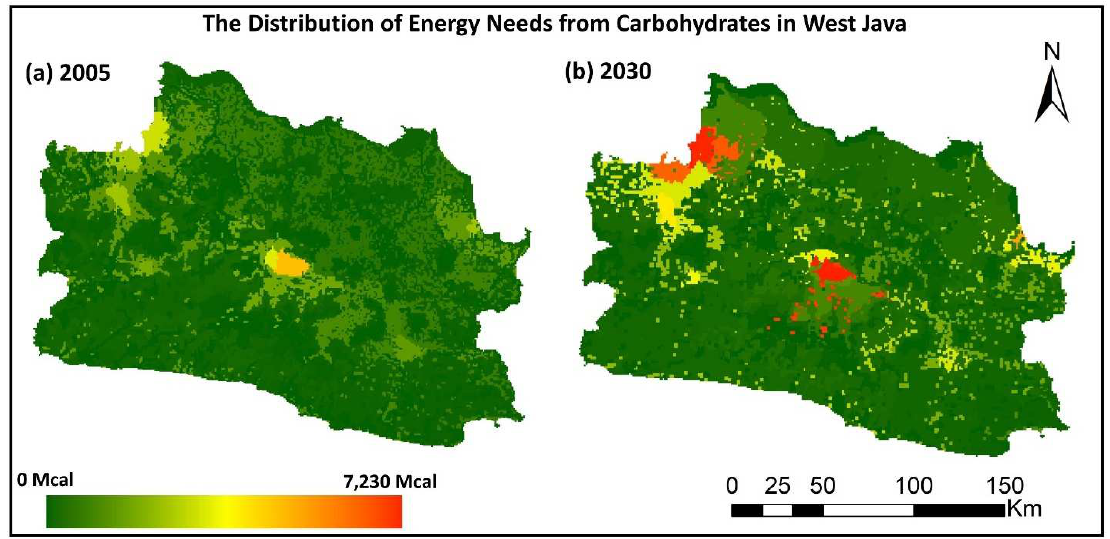
Figure 6. Energy needs (carbohydrates) in West Java in ( a ) 2005 and ( b ) predictions in 2030. The availability of food (carbohydrates) in 2005 in West Java reached 1975.995 Mcal per capita. The distribution of food availability in West Java in 2005 was dominated in the northern areas of West Java, namely Bekasi Regency, Karawang Regency, Subang Regency, Indramayu Regency, and Cirebon Regency, with the color index tending to be light green (medium). The prediction in food availability data (carbohydrates) in 2030 shows a decrease in availability compared to 2005. However, in terms of the productivity per capita, it has increased compared to 2005, which reached 2212.33 Mcal/capita. This result means that, although the land availability of food (carbohydrates) is reduced significantly, the paddy fields’ productivity level will have increased significantly in 2030. This condi- tion can be due to several supporting factors, such as natural factors and agricultural tech- nology, supporting productivity. The flow of food energy in West Java in 2005 was still able to cover food needs and obtain an energy surplus of 6.103 Mcal overall in West Java. Based on food needs (carbohydrates) and food availability (carbohydrates), it can be concluded that the status of food (carbohydrates) in West Java is as shown in Figure 7. The food surplus status means that the food availability is greater than the amount needed. This condition means that food availability in the region can still meet the current needs. On the other hand, a region experiencing a deficit means that the availability in that area cannot meet the current needs. Based on the results, most regions in West Java had a surplus status in 2005. Urban areas with a reasonably high demand, such as Bekasi City, Depok City, Bogor City, Bandung City, Sukabumi City, Tasikmalaya City, and Cire- bon City, have a deficit food status. The regencies such as Bandung Regency, Sukabumi Regency, and Bogor Regency also have a deficit food status. This status is because the food availability is relatively high and cannot meet the population’s needs.